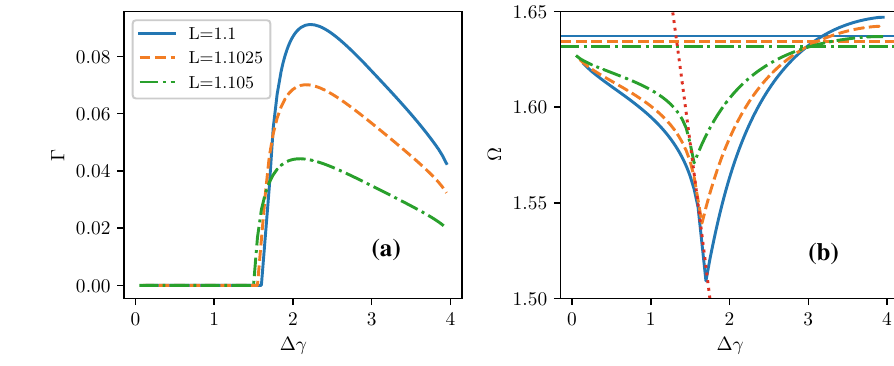
Fig. 5 a, b Analytical value of exponential decay rate and the frequency of oscillation, respectively, as a function of (cid:8)γ . Parameters are